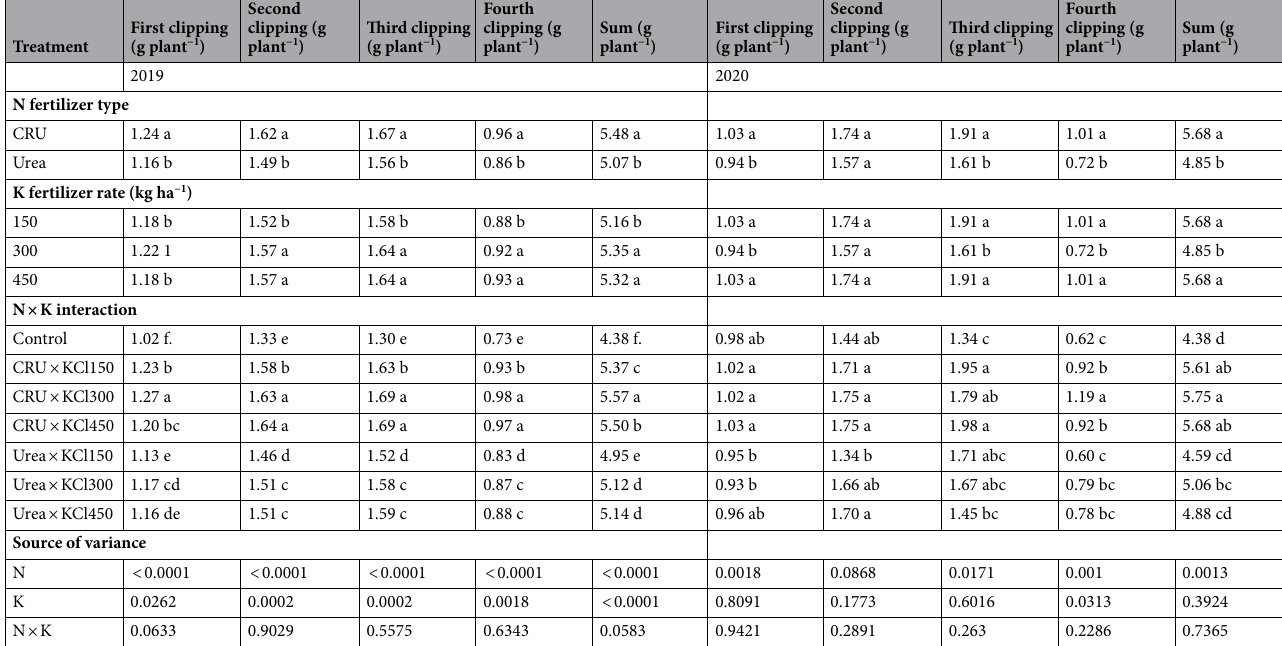
Table 6. The dry yield of Italian ryegrass in 2019 and 2020. Means followed by different lowercase letters in the same column were significantly different based on analyses with ANOVAs followed by Duncan